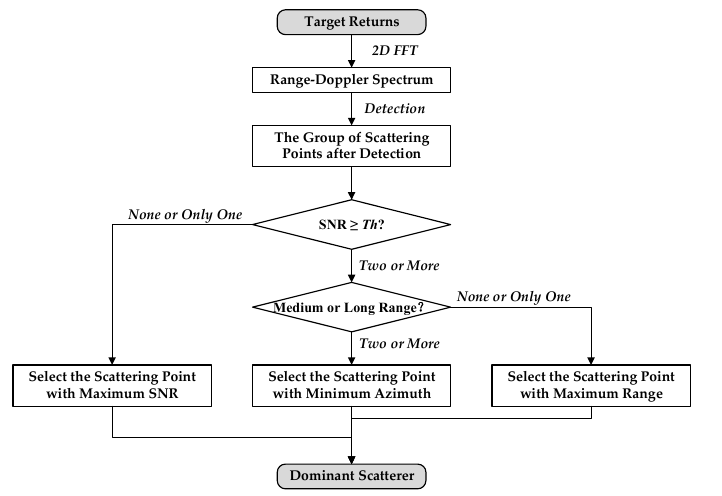
Figure 11. The selection procedure of the dominant scatterer, where Th is set to 13 dB in this paper.